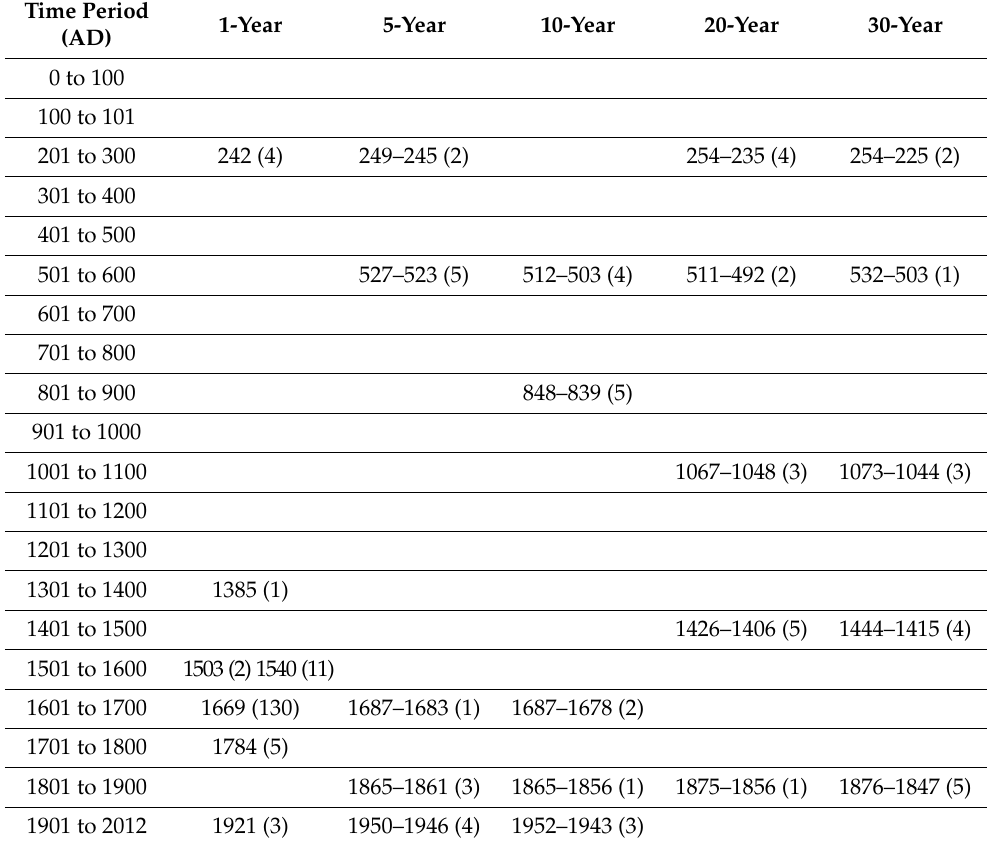
Table 2. Drought periods (1-year, 5-year, 10-year, 20-year, and 30-year) for the PRB regional recon- struction from 0 to 2012 AD. The number in the parenthesis represents the drought period